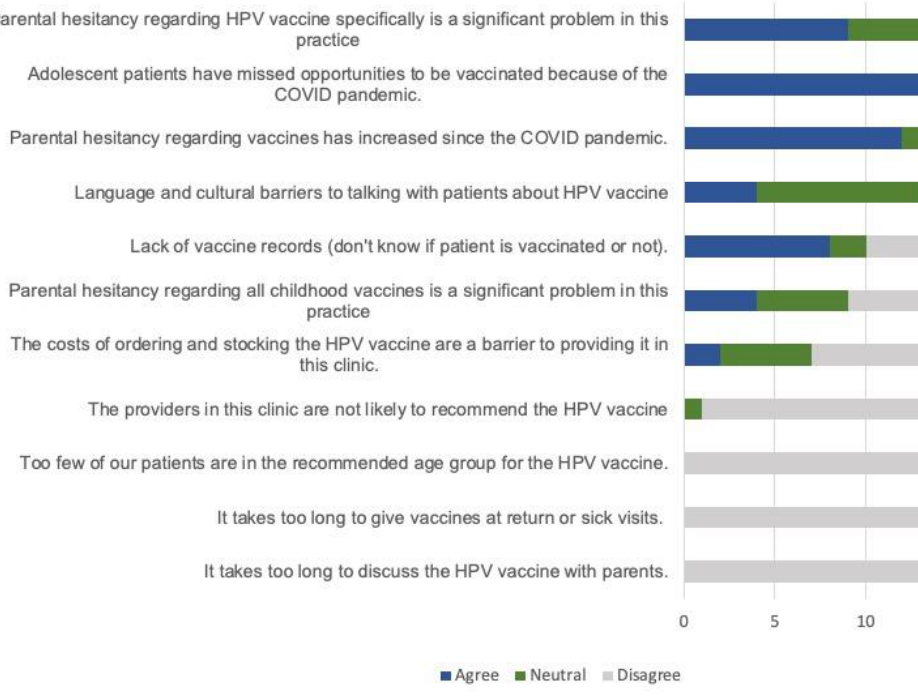
Figure 1. Perceived barriers to HPV vaccination.